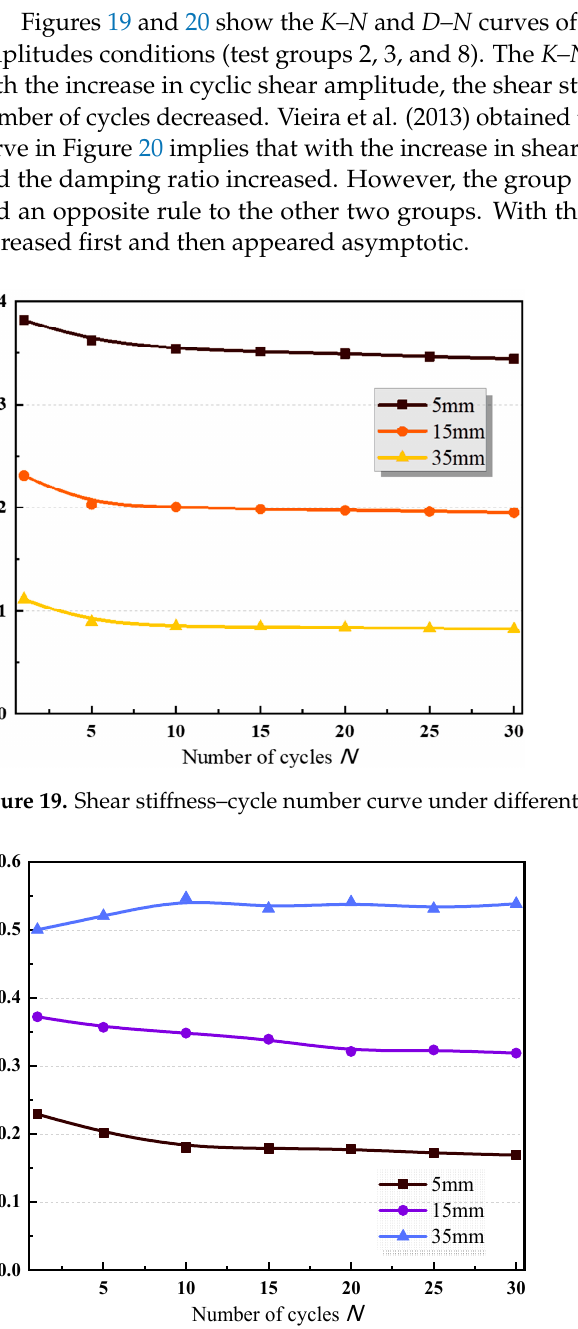
Figure 20. Damping ratio–cycle number curve under different shear amplitude levels.